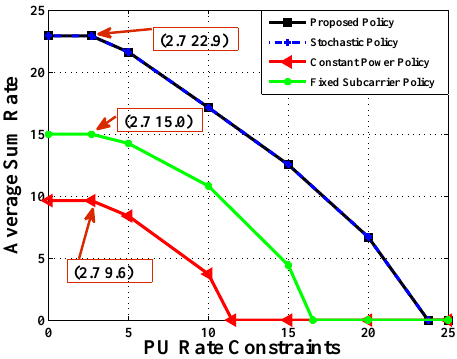
Figure 3: Average sum rate (Nats/s) versus the PU rate constraints (Nats/s). α = 5 , P s = 10